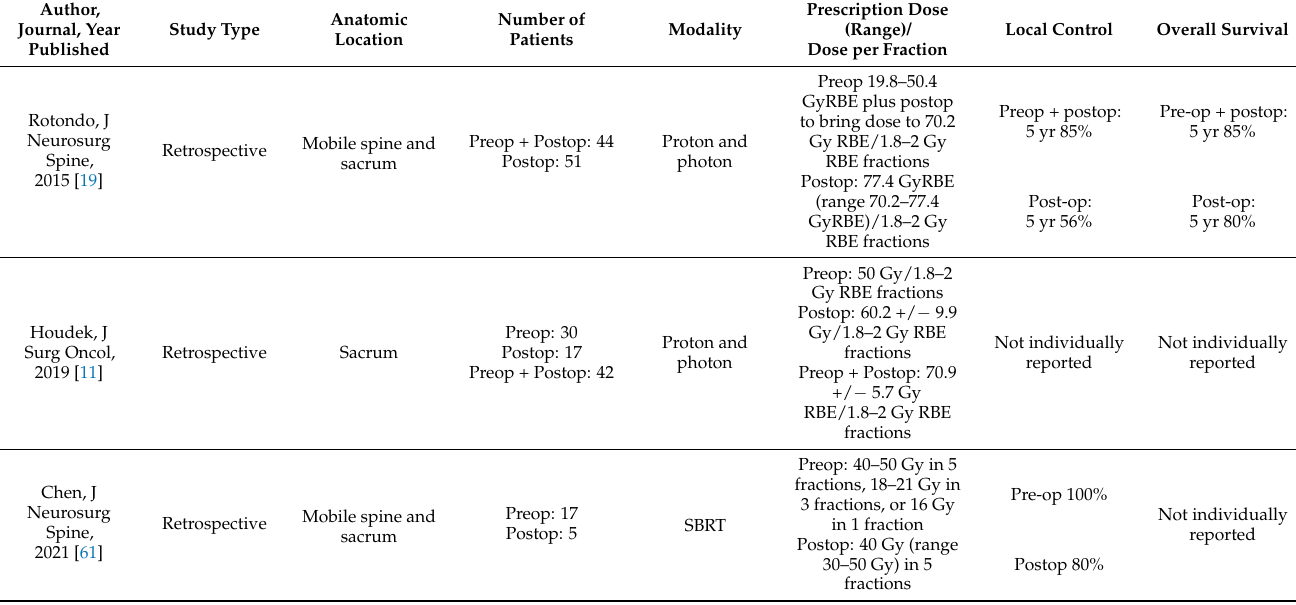
Table 5. Comparison of preoperative and postoperative radiation therapy for intact and de novo mobile spine/sacral